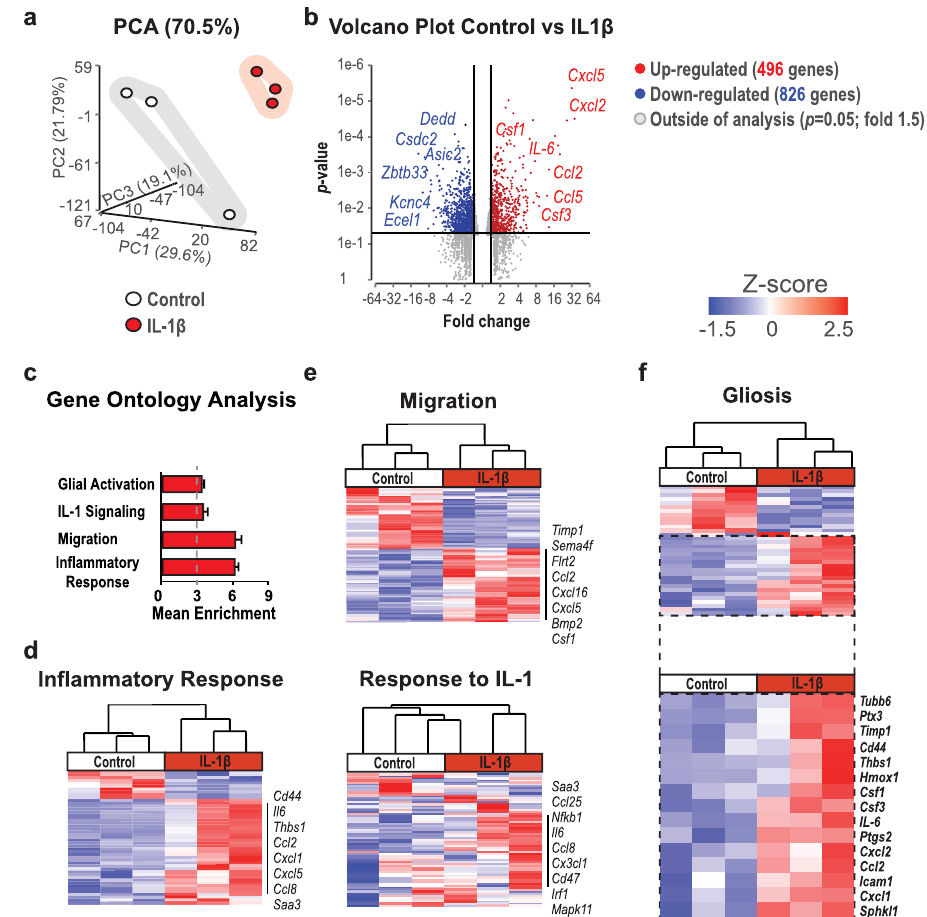
Fig. 1 IL-1 induces a speci fi c reactive phenotype in EGCs. EGCs were treated with IL-1 β (10 ng/ml) or vehicle (control) for 24 h and processed for bulk- RNA-Seq. a PCA plot shows a clear separation between both groups. b Volcano plot showing all signi fi cantly regulated genes. c Gene ontology (GO) analysis of IL1 β -treated EGCs showing enrichment of genes connected to the indicated GO terms. d , e Heat maps of differentially expressed genes involved in “ in fl ammatory response ” , “ migration ” , and “ response to IL-1 ” between IL-1 β - and vehicle-treated EGCs. f Heat map of genes involved in “ gliosis ” highlighting the induced gene panel. Statistics were done with Fisher ’ s exact test, n = 3 per